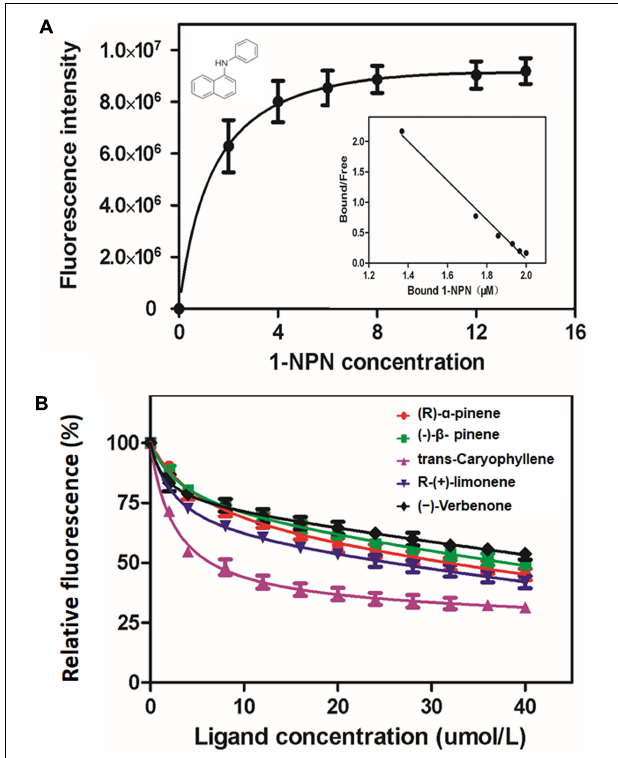
FIGURE 3 | Binding affinity of MaltOBP1. (A) Binding curve and relative Scatchard plot of MaltOBP1 and 1-NPN. (B) Competitive binding curves of selected volatile host plant compounds to